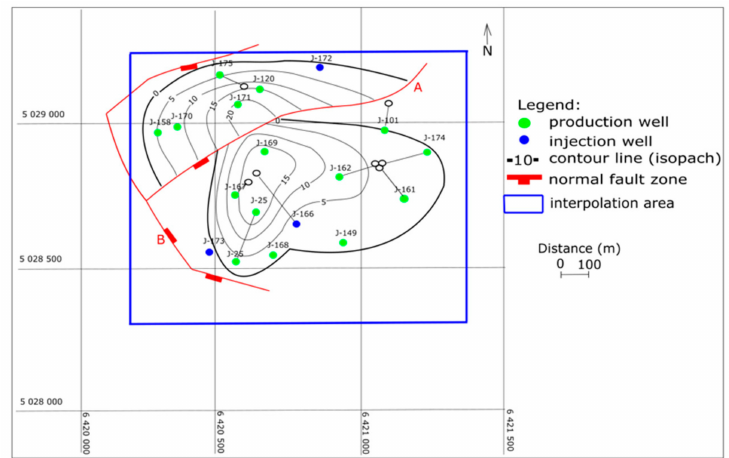
Figure 4. Thickness (isopach) map of the reservoir “K”, with borders of interpolated area, fault zone and (injection and production)